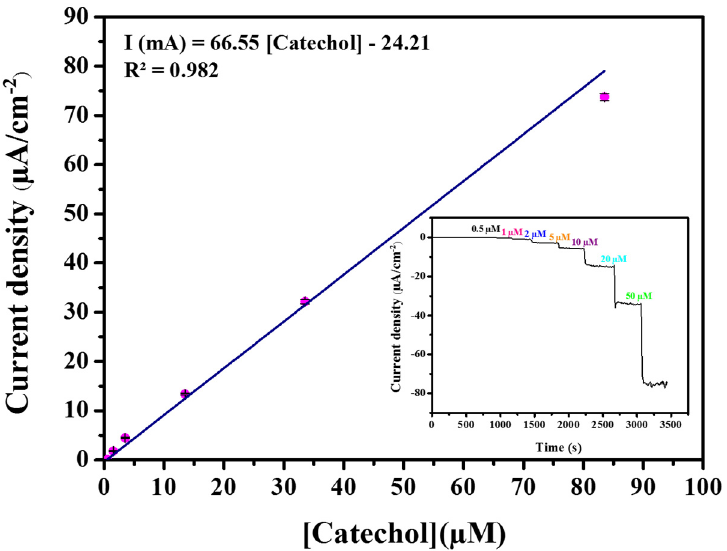
Figure 1. Calibration curve obtained by a CBPE-tyrosinase modified electrode in 0.1 M phosphate buffer, pH 6.8 at − 0.15 V vs. Ag/AgCl. Standard errors are indicated by bars of three repeated measurements (n = 3). Inset represents a typical response to successive catechol injections. Table 1. Comparison of analytical performances of the Tyr-CBPE biosensor obtained for determi- nation of catechol with others studies reported in the literature.